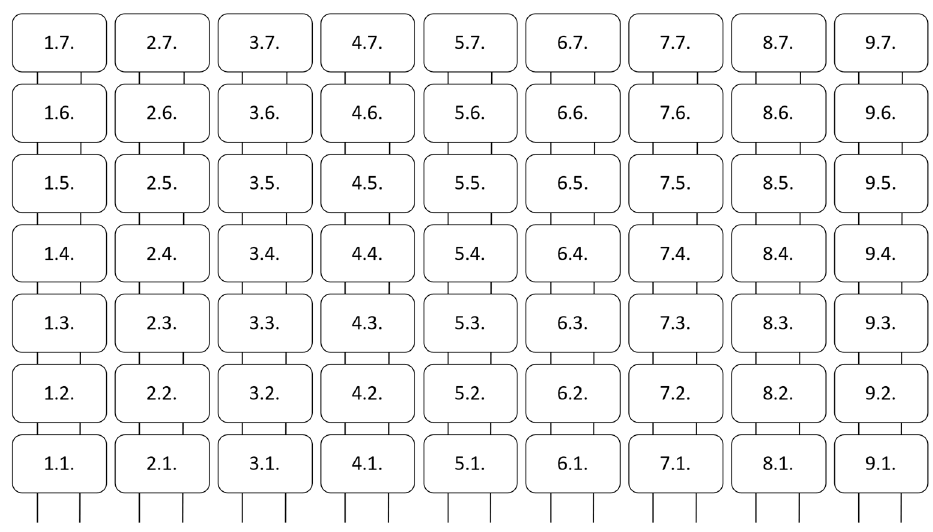
Figure 8. The placement and numbers assigned to containers.